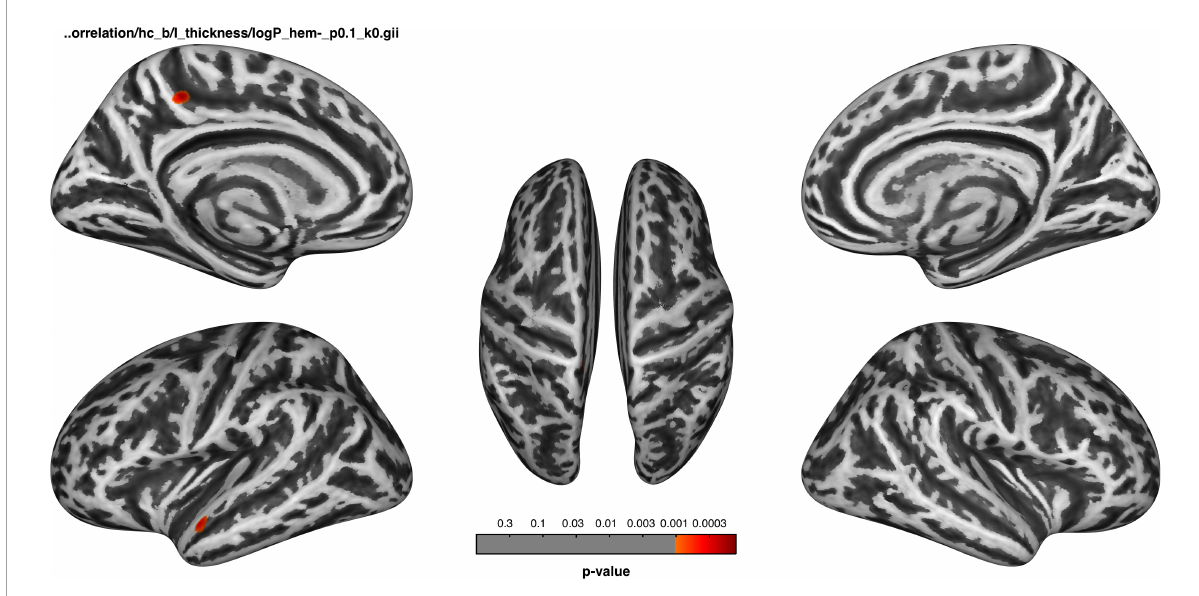
FIGURE2 Before dialysis, the thickness of the left superior temporal cortex and precuneus was negatively correlated with the duration of